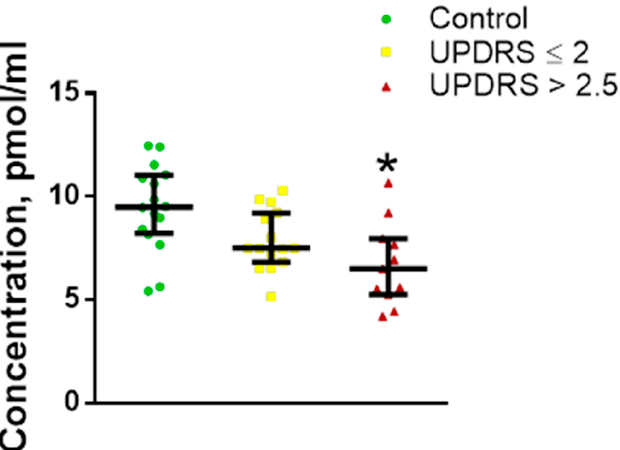
Figure 7. L-3,4-dihydroxyphenylalanine (L-DOPA) concentration in the risk subgroup with mild non-Parkinsonian motor impairment (UPDRS > 2.5 points) and in the risk subgroup without motor impairment (UPDRS ≤ 2 points) compared with control. * p < 0.05, statistically significant differences. UPDRS—Unified Parkinson’s Disease Rating Scale. Data presented as a median with an interquartile range and min–max values.